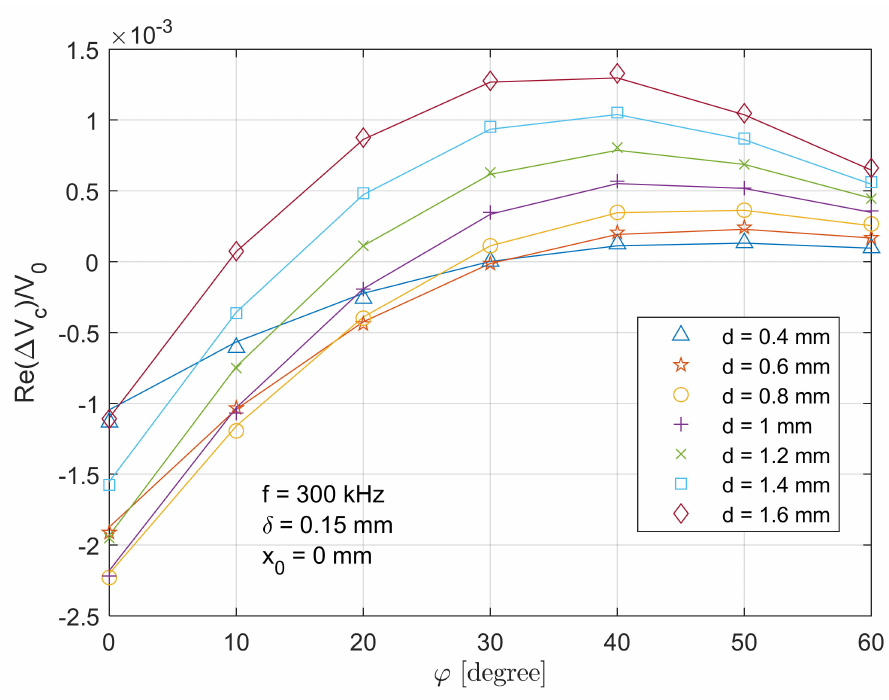
Figure 13. Comparison of analytical (lines) and experimental (markers) results for the real part of normalised voltage change (due to the crack) versus tilt angles when the T-R sensor is above the crack centre ( x 0 = 0 mm).